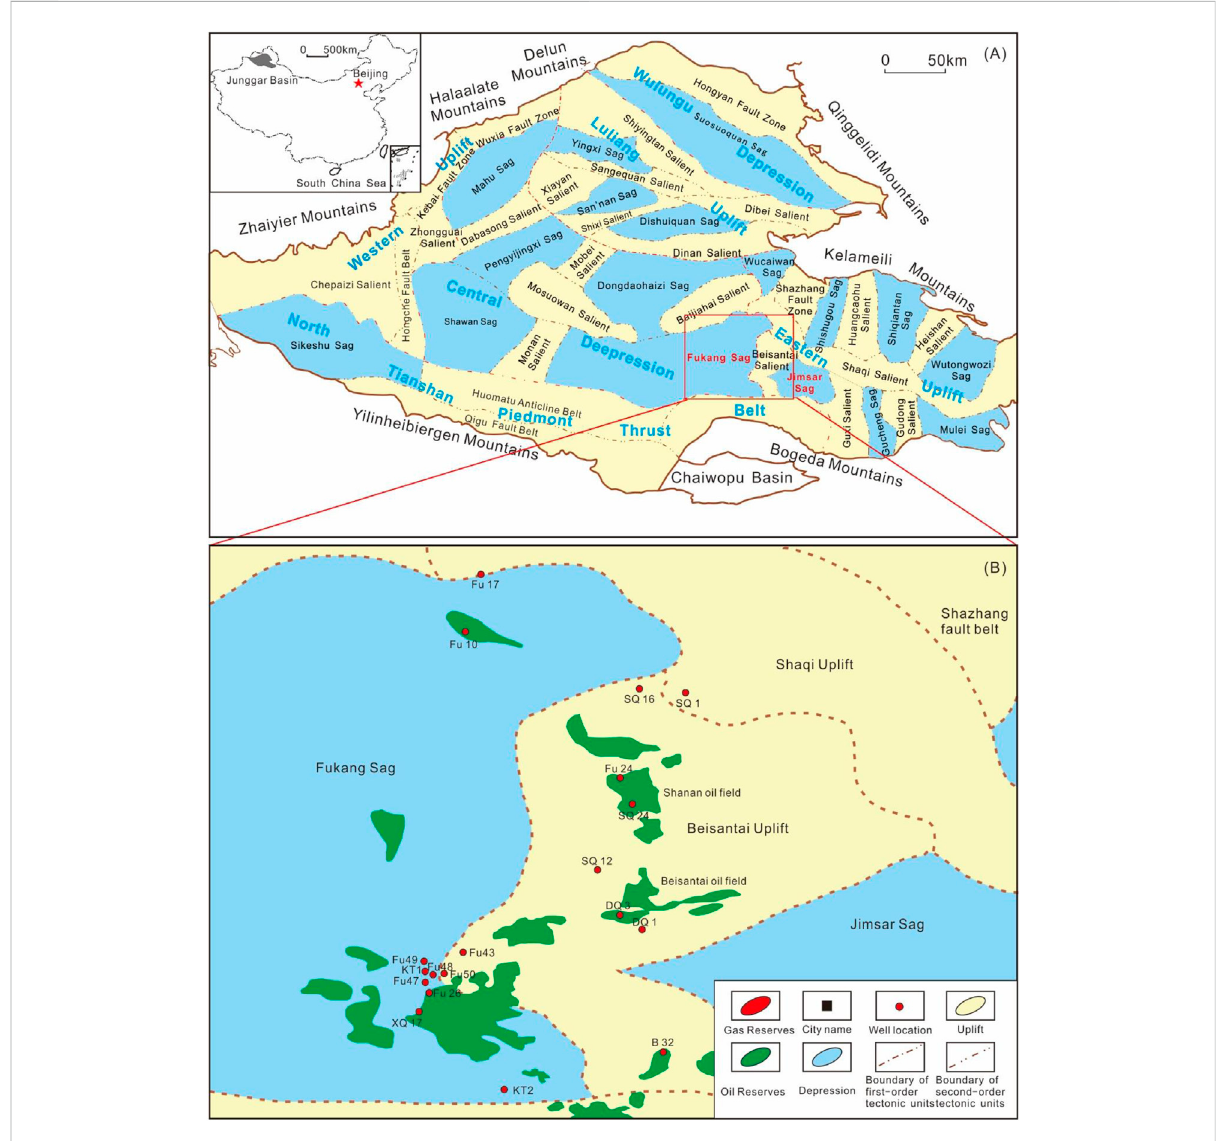
FIGURE 1 Tectonic units in the Junggar Basin and the location of Fukang Sag (after Lian et al., 2011; Gong et al., 2019).